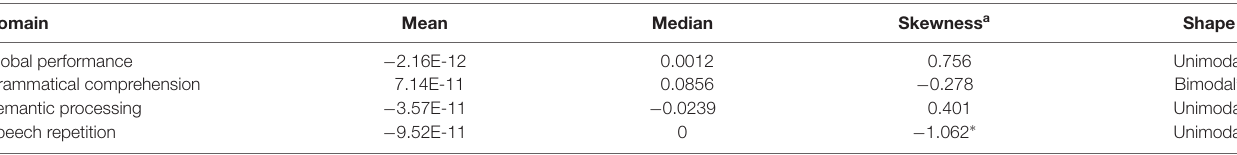
TABLE 3 | Model residuals for each domain of